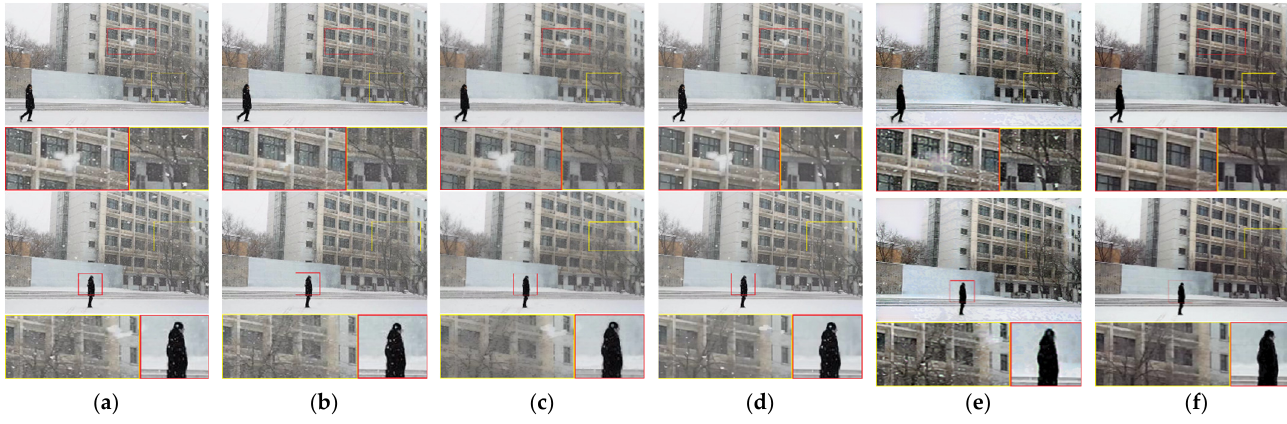
Figure 8. Comparison on a real snow video. ( a ) Input, ( b ) Kim et al. [16], ( c ) Wang et al. [8], ( d ) Li et al. [14], ( e ) Chen et al. [32], ( f ) proposed method.